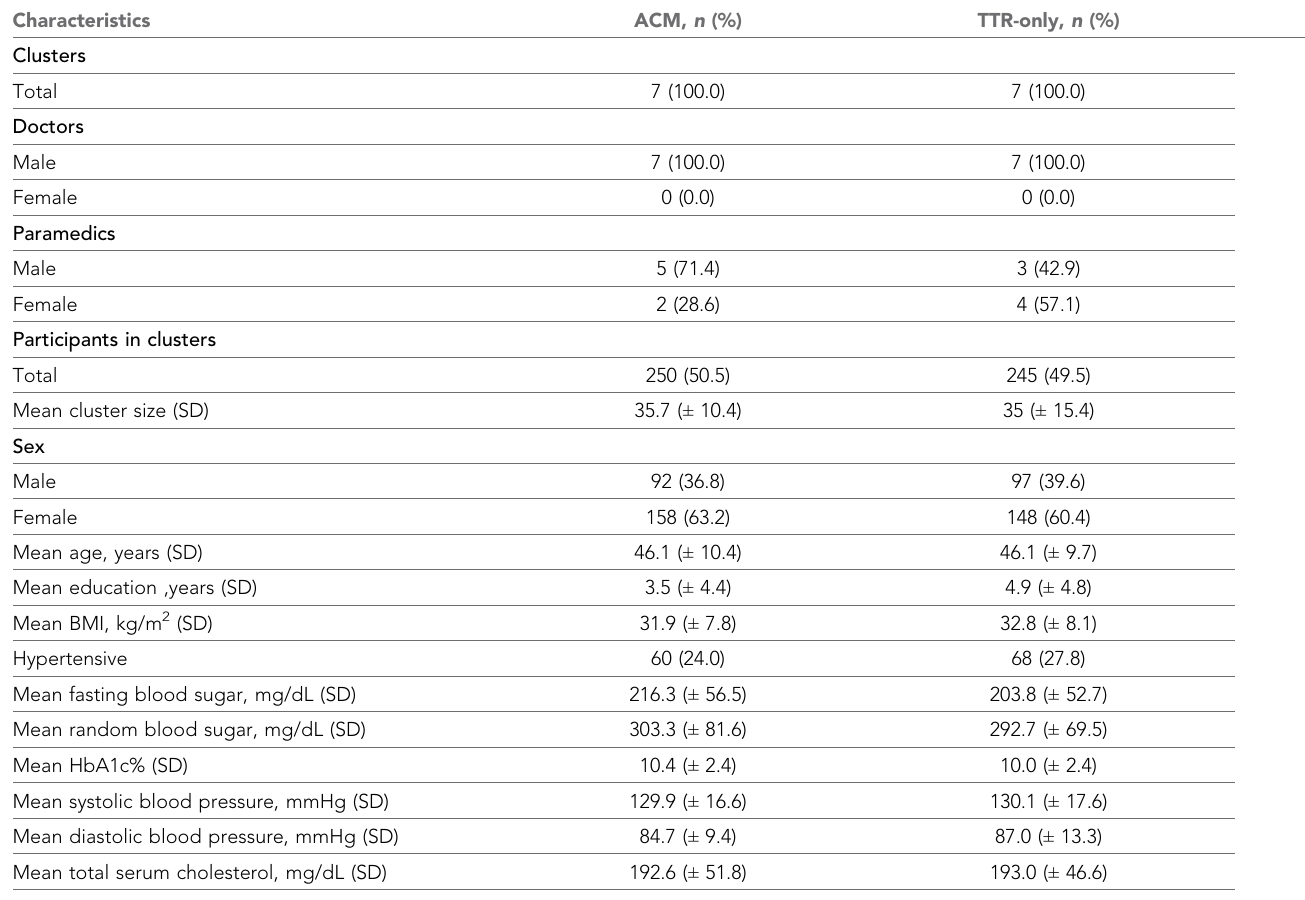
Table 1. Baseline characteristics of clusters and patients